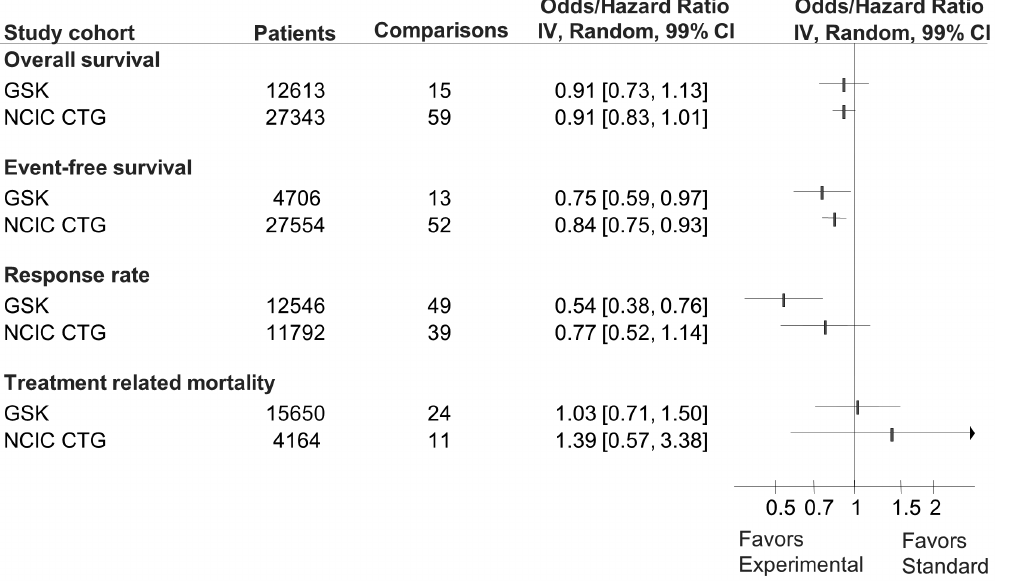
Figure 4. Forest plot of distribution of success rate for outcomes of overall survival, event-free survival, response rate, and treatment relate mortality for GlaxoSmithKline (GSK) and National Cancer Institute Canada Clinical Trials Group (CTG) cohorts. The summary pooled estimate (odds/hazard ratio) is indicated by rectangles, with the lines representing 99% confidence intervals (CIs). Note that unlike for the pooled analysis for all primary outcomes (Fig 2) test of interaction detected no statistically significant difference between subgroups, but the number of comparisons was too small to detect a difference between two cohorts.